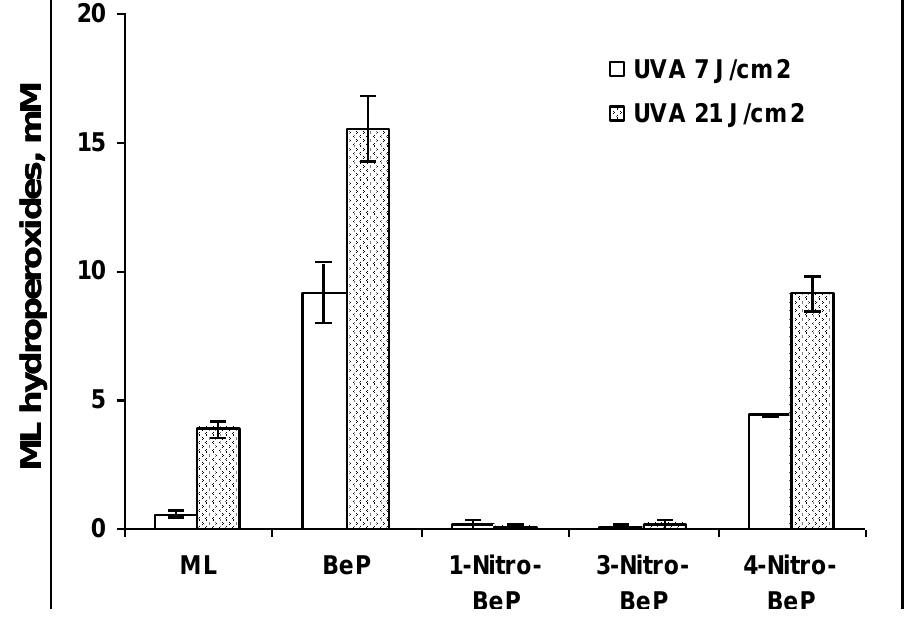
Figure 4. Lipid peroxidation induced by photoirradiation of BeP, 1-nitro-BeP, 3-nitro-BeP, and 4-nitro-BeP in methanol in the presence of methyl linoleate (ML) with UVA light at a light dose of 7 and 21 J/cm 2